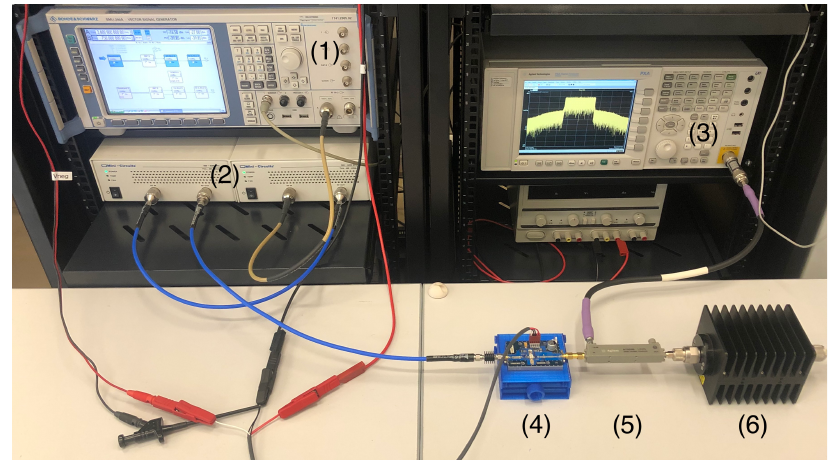
Figure 3. Photograph of the experimental setup composed of (1) a vector signal generator, (2) two cascaded preamplifiers, (3) a vector signal analyzer, (4) the class AB PA under test, (5) a directional coupler, and (6) an attenuator terminated with a 50 Ω